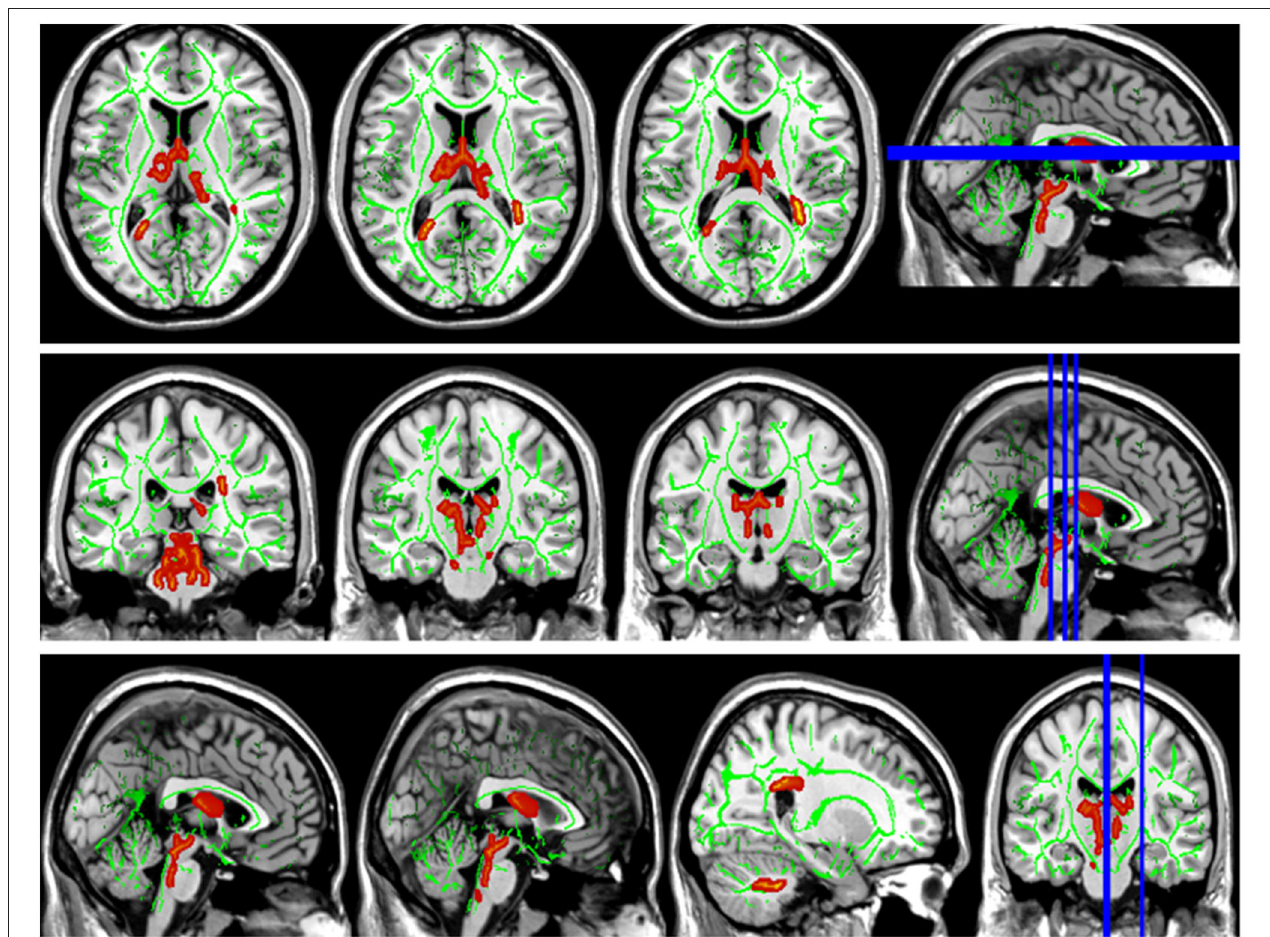
FIGURE 2 | Group differences in mean diffusivity (MD). The MD values in patients with LAN and RAN increased in left anterior thalamic radiation, right inferior fronto-occipital fasciculus, and major